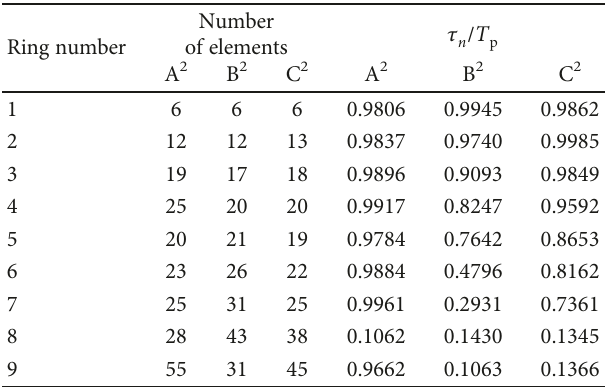
Table 5: The numbers of elements and the normalized switch-on time sequences for individuals A 2 , B 2 , and C 2 .